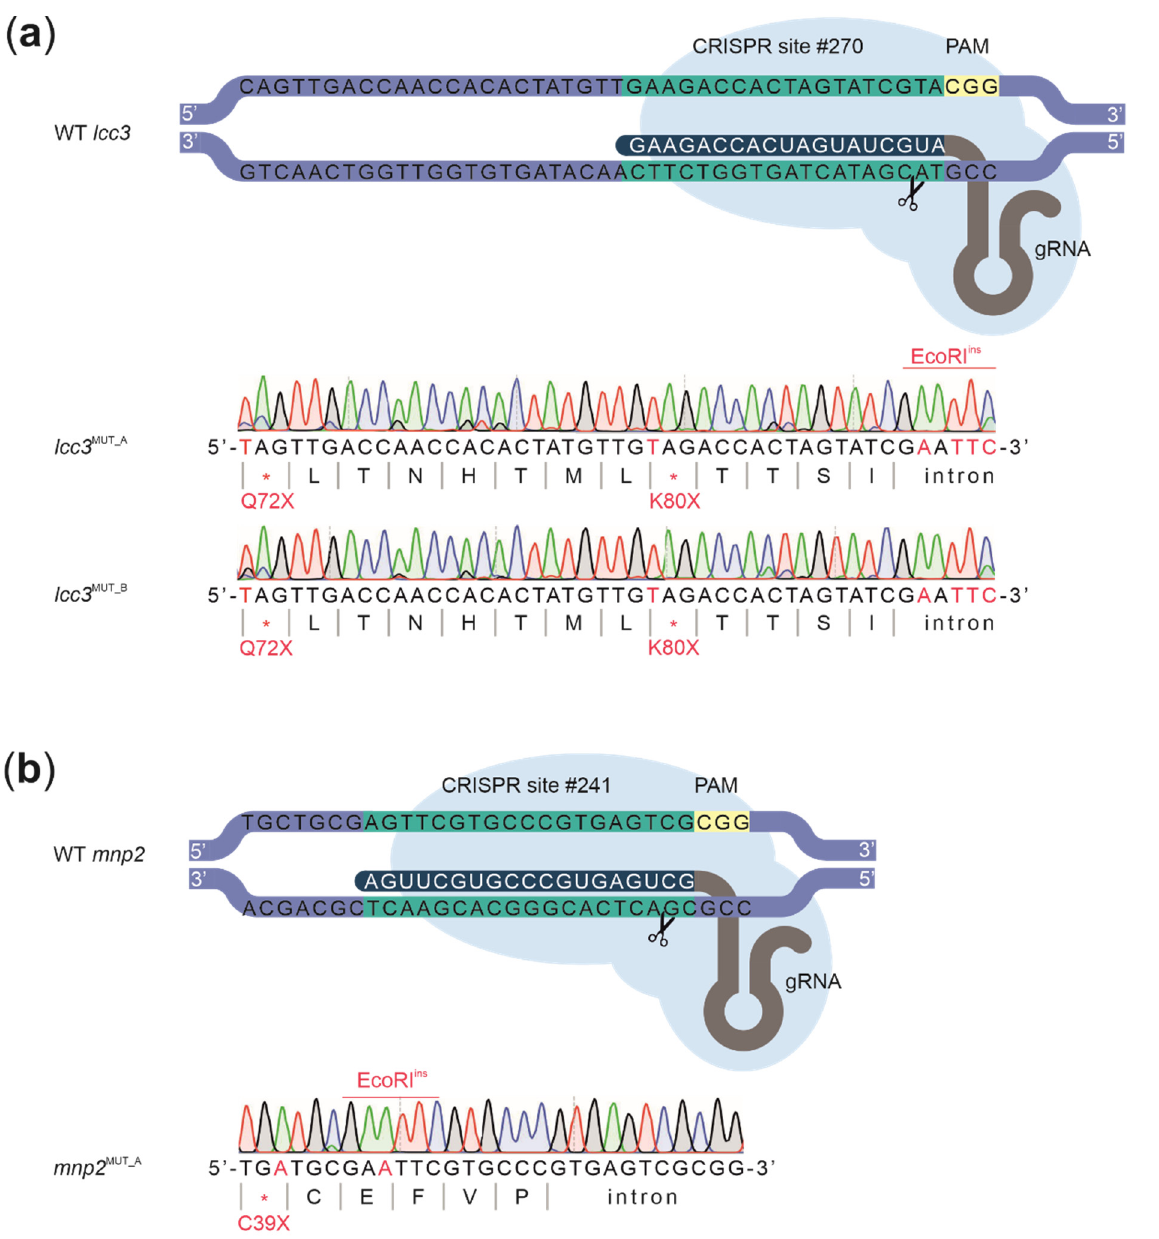
Figure 5. Schematic representation of the Cas9 target site in the lcc3 and the mnp2 gene of the wild type D. squalens (WT): ( a ) two knockout mutants, lcc3 MUT_A and lcc3 MUT_B , with the shown edits were obtained and ( b ) for the mnp2 , a knockout mutant mnp2 MUT_A with the shown edits was obtained. * = STOP codon